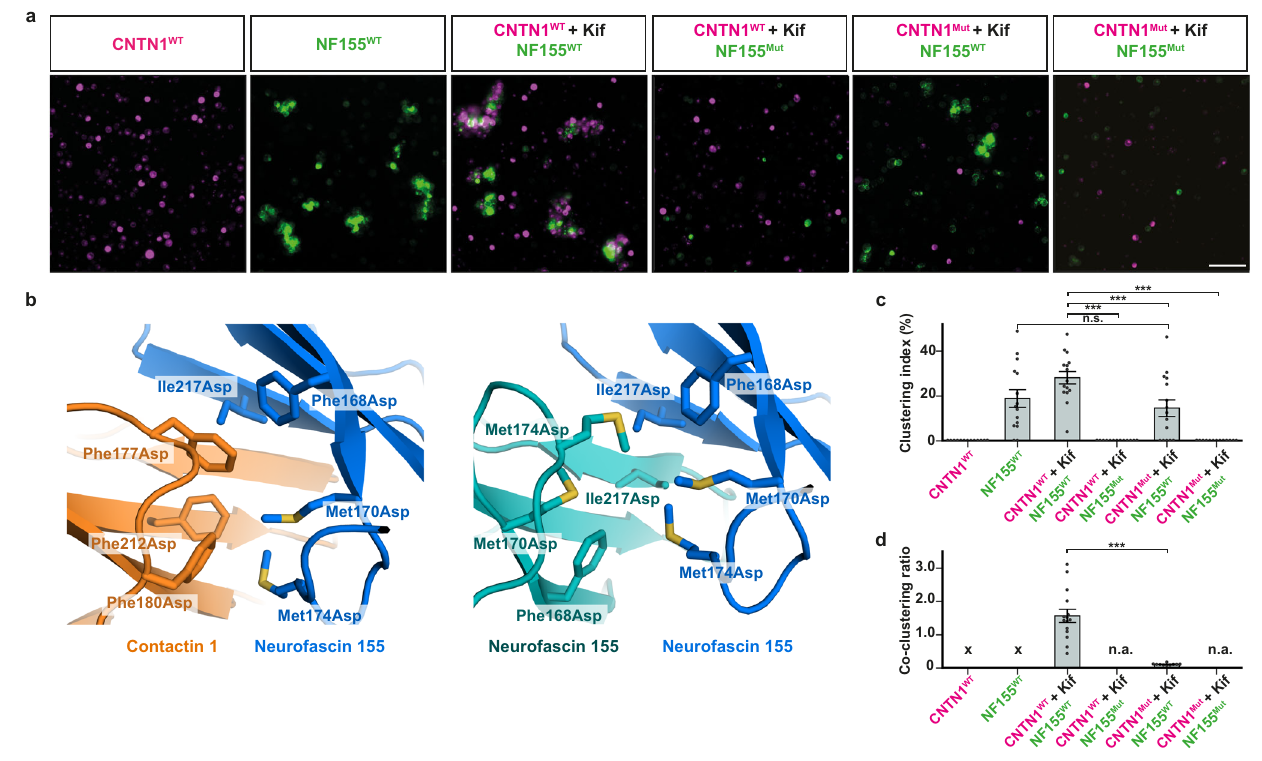
Fig. 5 | Contactin 1 – neurofascin 155 expression mediates cell co-clustering. a Representative cell clustering images of K562 cells expressing contactin 1 (mCherry; magenta; CNTN1) and neurofascin 155 (GFP; green; NF155). Wildtype contactin 1 – neurofascin 155 co-clusters form when contactin 1 is expressed in the presenceofkifunensine(Kif;10 µ M).Neurofascin155butnotcontactin1-expressing cells exhibit homophilic clustering. Mutation of the competitive interface residues on either protein abolishes co-clustering. Each experiment was repeated three timesindependentlywithsimilarresults.Scalebar,100 µ m.Contactin1Phe177Asp, Phe180Asp and Phe212Asp is CNTN1 Mut , neurofascin 155 Phe168Asp, Met170Asp, Met174Asp and Ile217Asp is NF155 Mut . b Location of the mutations. Contactin 1 – neurofascin 155interface residues, shownin stick representation,at the “ bottom side ” of the Ig2 super β -sheet (left panel) are mutated to aspartates and prevent heterophilic trans interactions. The same neurofascin 155 residues are also located in the neurofascin 155 homodimer interface (right panel) and mutating them to aspartates prevents homophilic trans interactions. c Clustering index; the pro- portion of the total segmented cell area classi fi ed as clusters. p values are: 0.9544